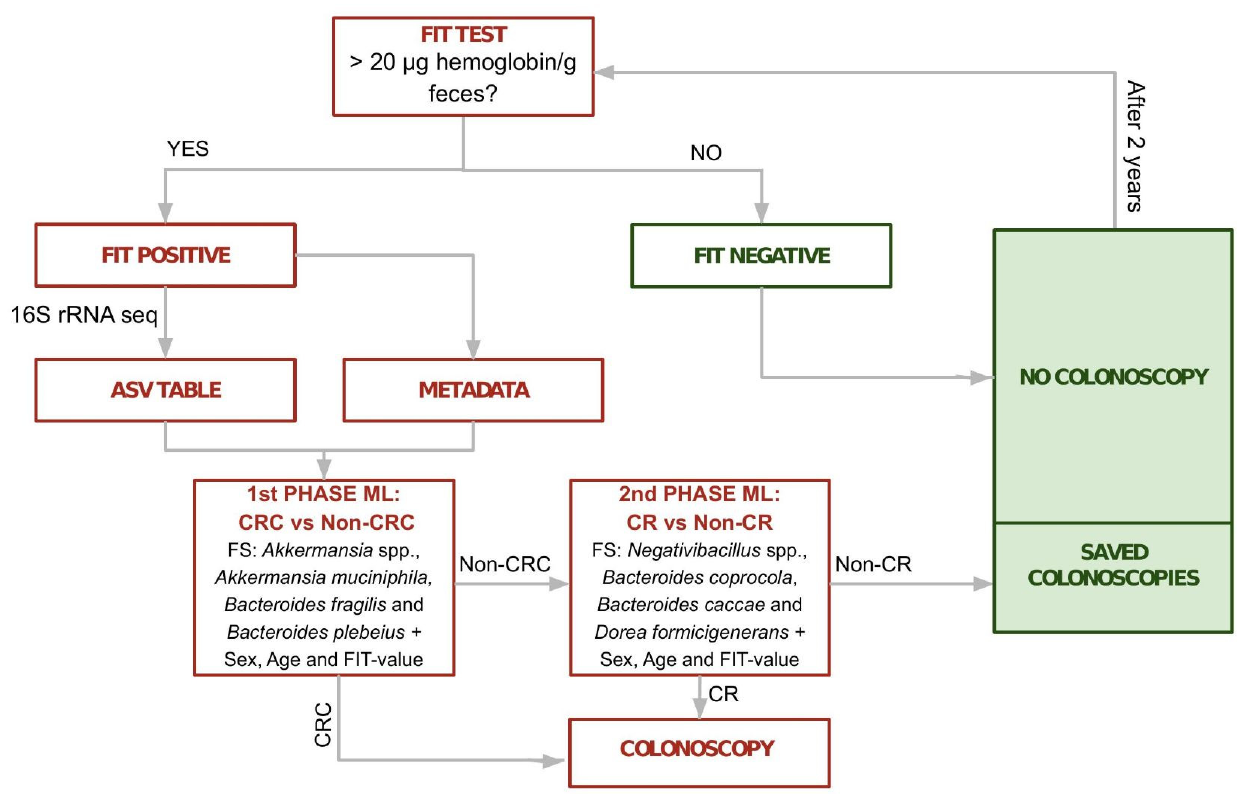
Figure 5. Flow chart of the proposed methodology (4-4 taxa classifier). FIT positive samples are subjected to microbiome profiling by 16S rRNA gene sequencing. Then a two phase classifier is applied. First the algorithm classifies CRC vs. non-CRC samples. Samples that are classified as non-CRC in the first phase are subjected to a second model that classifies CR vs. non-CR samples. FIT: fecal immunochemical test; CRC: colorectal cancer, CR: clinically relevant.